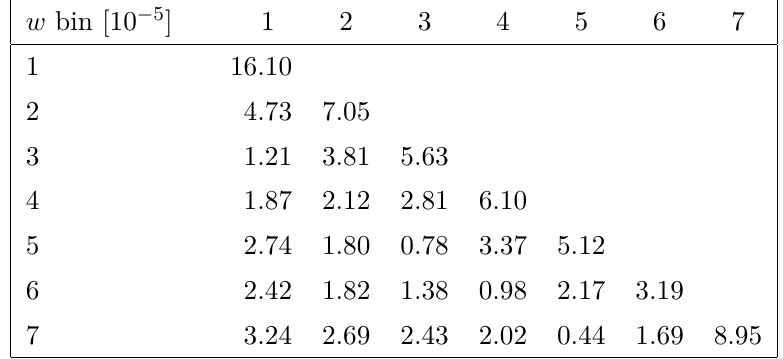
Table 6 . Covariance matrix for the unfolded data set in bins of w , including both statistical and systematic uncertainties in units of 10 − 5 .